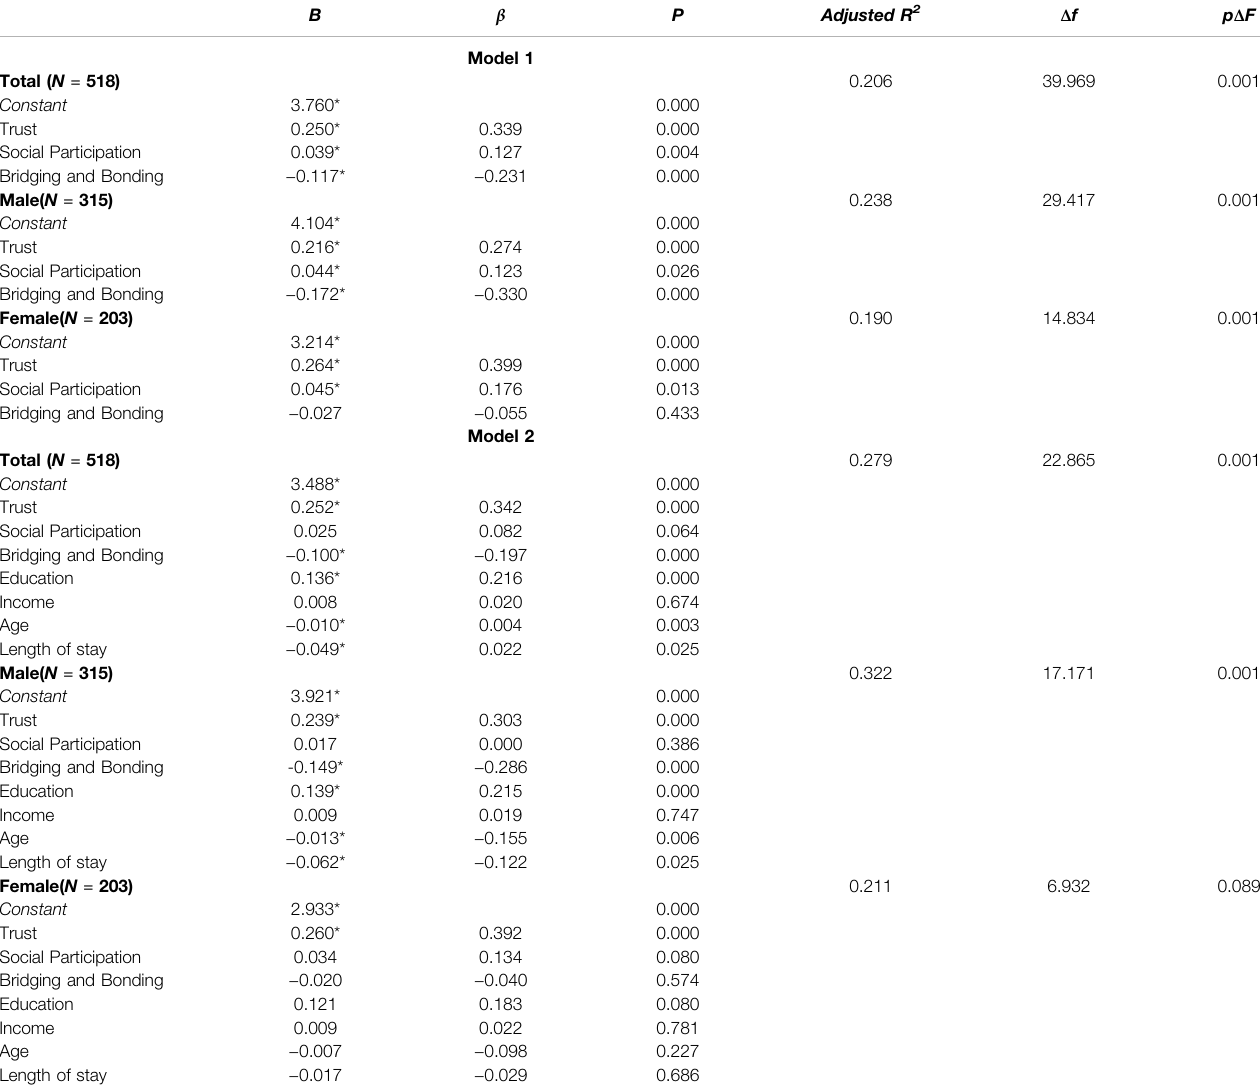
TABLE 4 | Hierarchical multiple regression models exploring trust, sociability, and quality of life among SSA migrants in Germany. B